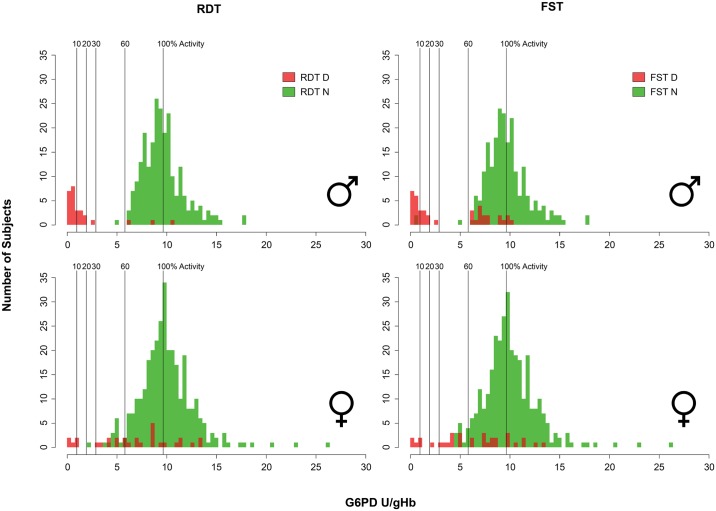
Graphs illustrate diagnostic outcomes for the G6PD RDT (left) and FST (right) among males (top) and females (bottom) across quantitative G6PD activity values for each subject.A qualitative test classification as deficient is shown in red, and green for normal. Vertical lines within each identify specific diagnostic thresholds (10%, 20%, 30%, 60% and 100%) employed to calculate diagnostic performance characteristics.